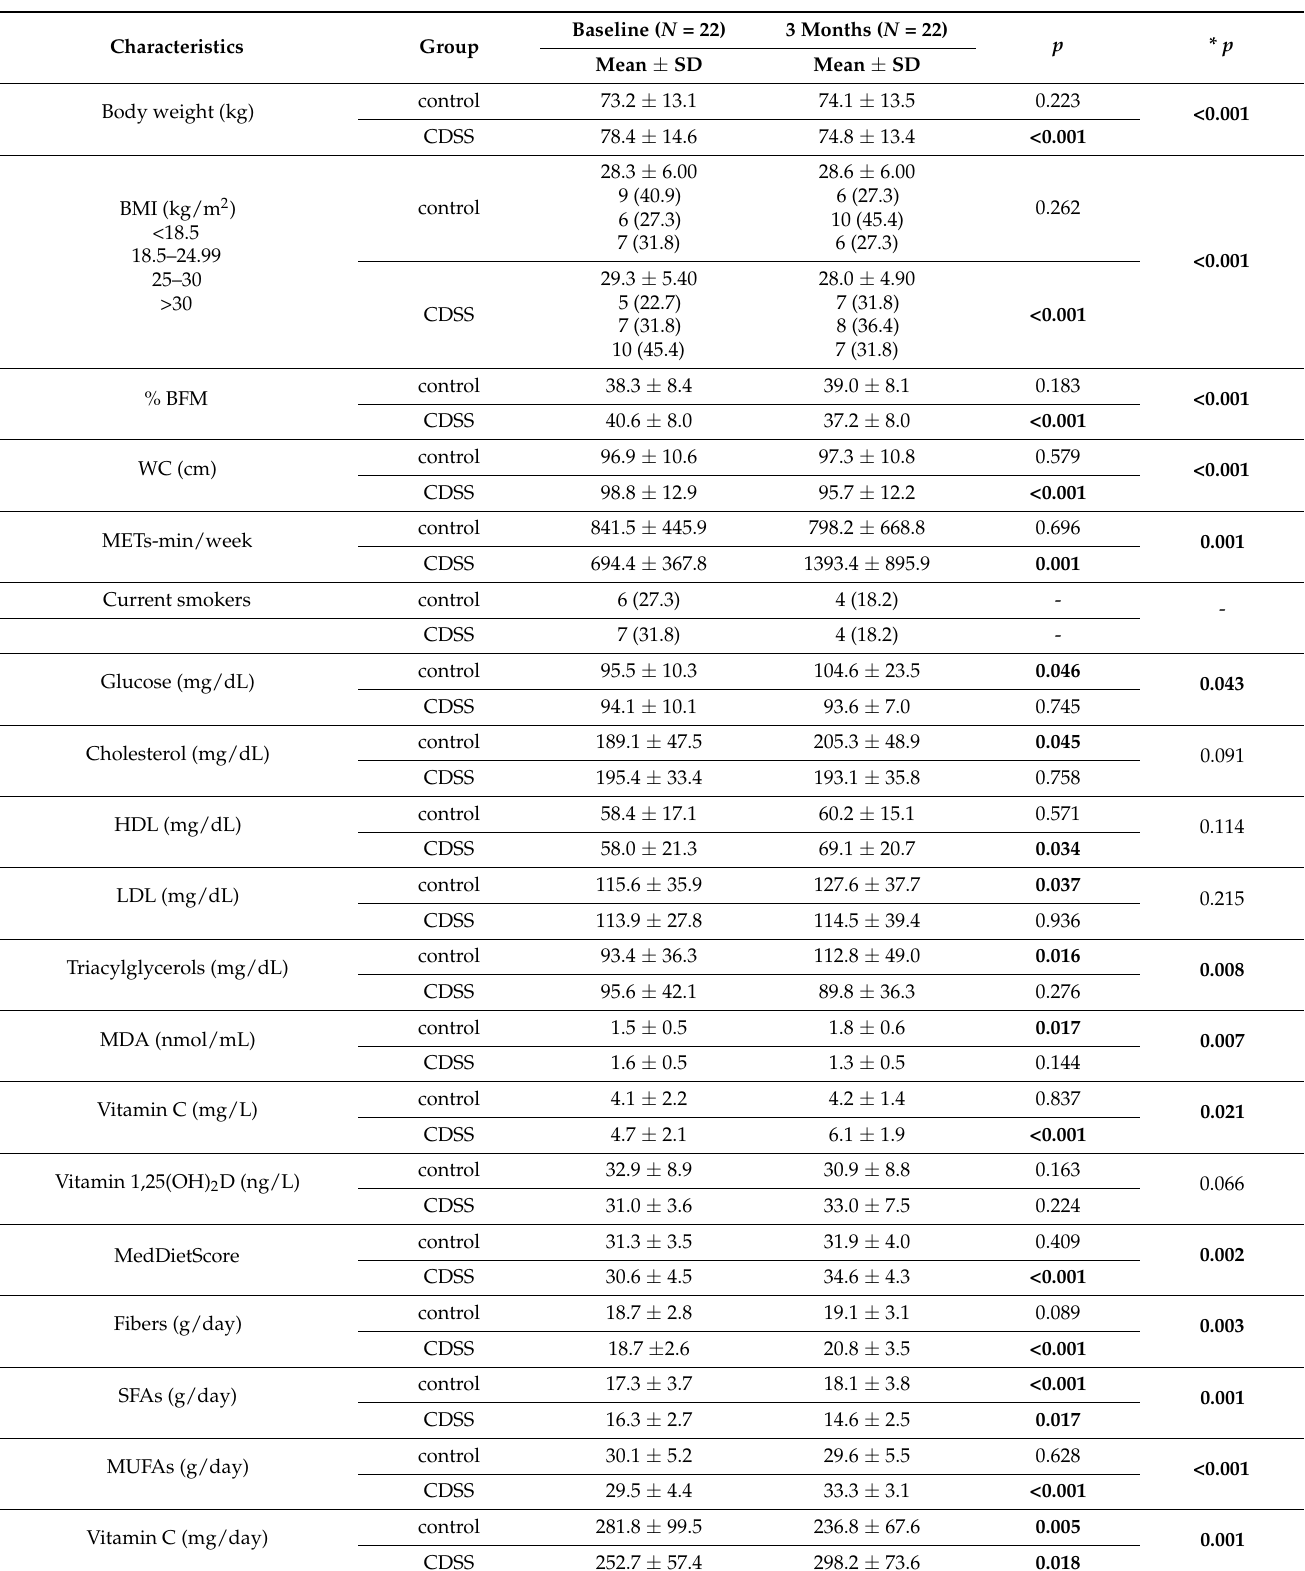
Table 3. Characteristics of BC patients at baseline and study end (3